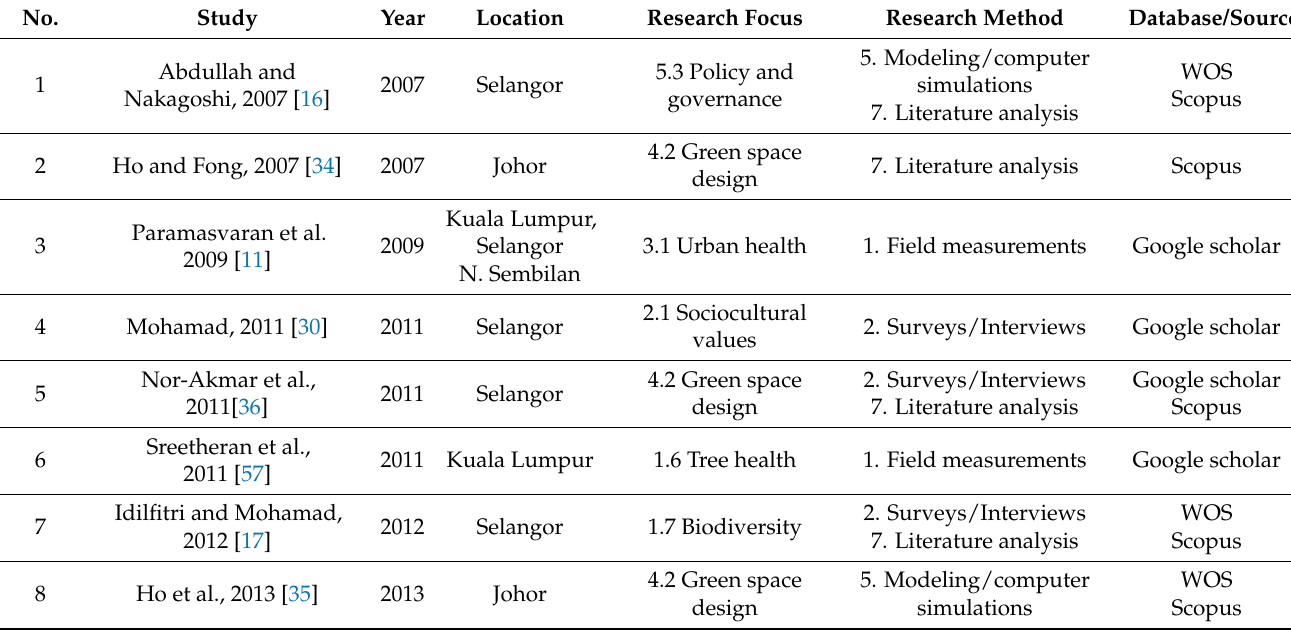
Table A1. Articles selected for this review ( n =